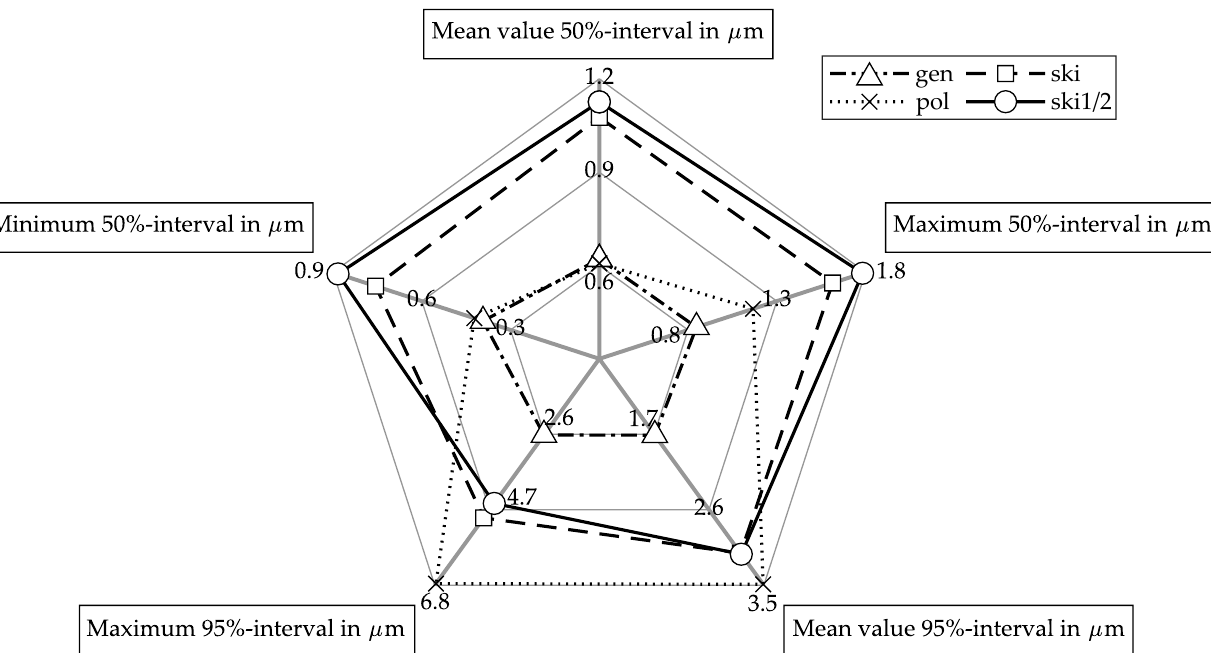
Figure 20. Overview of specific values of the deviations shown in the box plots of all tested